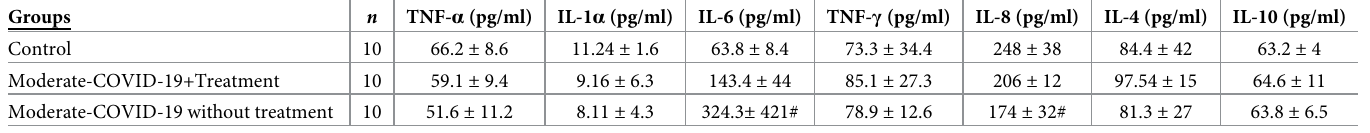
The data are means ± standard errors. P value < 0.05 for a comparison with the control group, n = number of patients